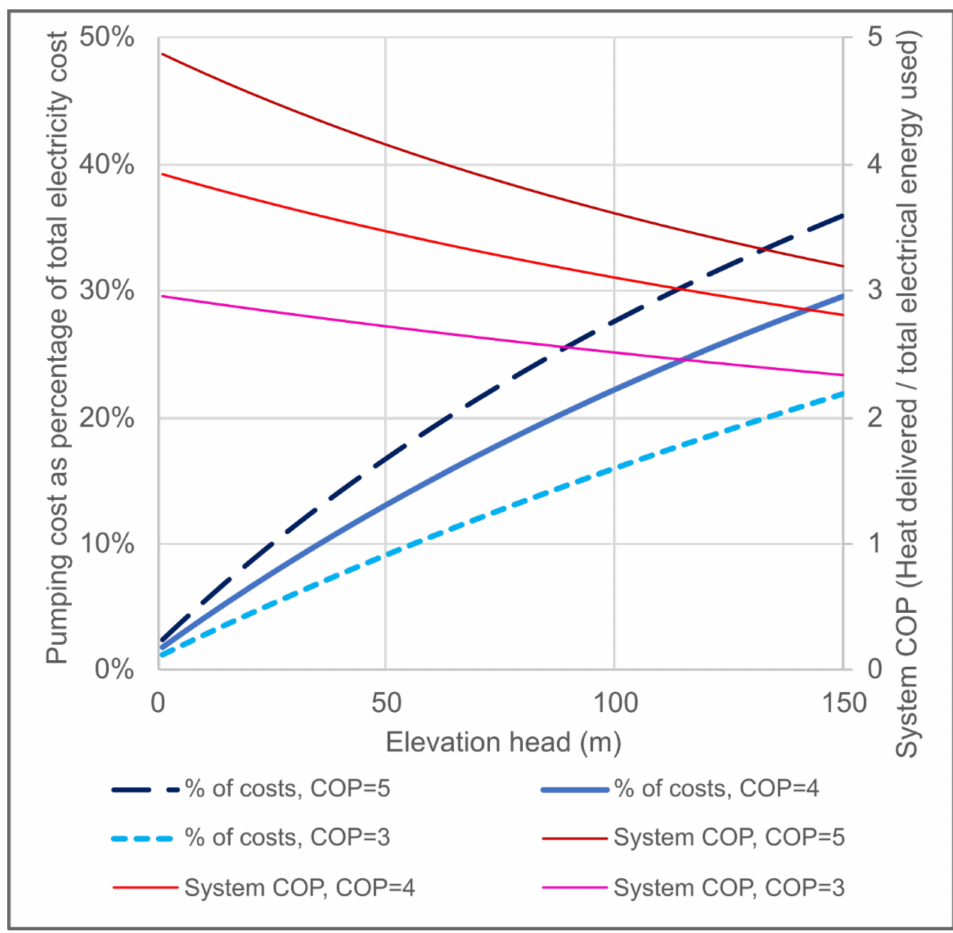
Figure 8. Hydraulic pumping costs, as a % of total electricity cost, and system COP, as a function of elevation head (elevation up which water is pumped). A constant frictional head loss of 6 m is added to the elevation head loss. Only water pumping and heat pump power and costs are considered. The heat pump COP is set at values of 3, 4 and 5. System COP is defined as Total heat output (kW)/Total electricity use (kW). Other assumptions: water density of 1 kg/L, temperature change across heat pump = 4 ◦ C, volumetric heat capacity of water = 4.19 kJ/L/ ◦